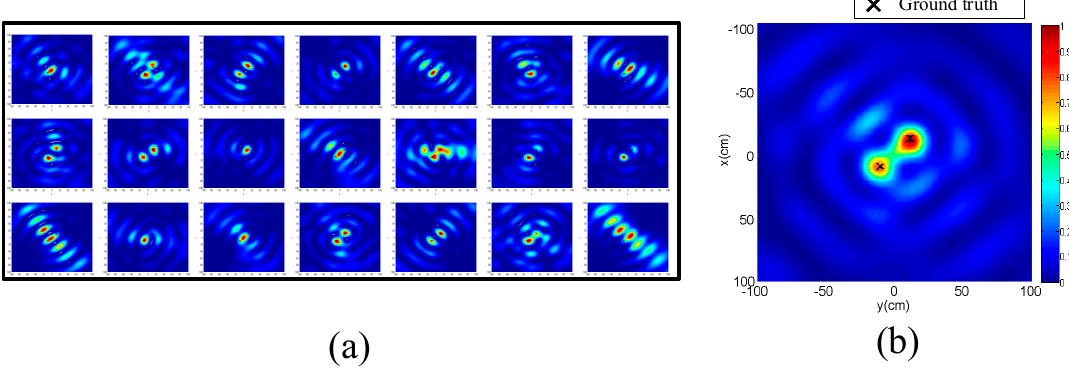
Figure 13. Weighted spatial averaging process: ( a ) the initial 21 spatial spectrums, and ( b ) the spatial spectrum after spatial averaging.